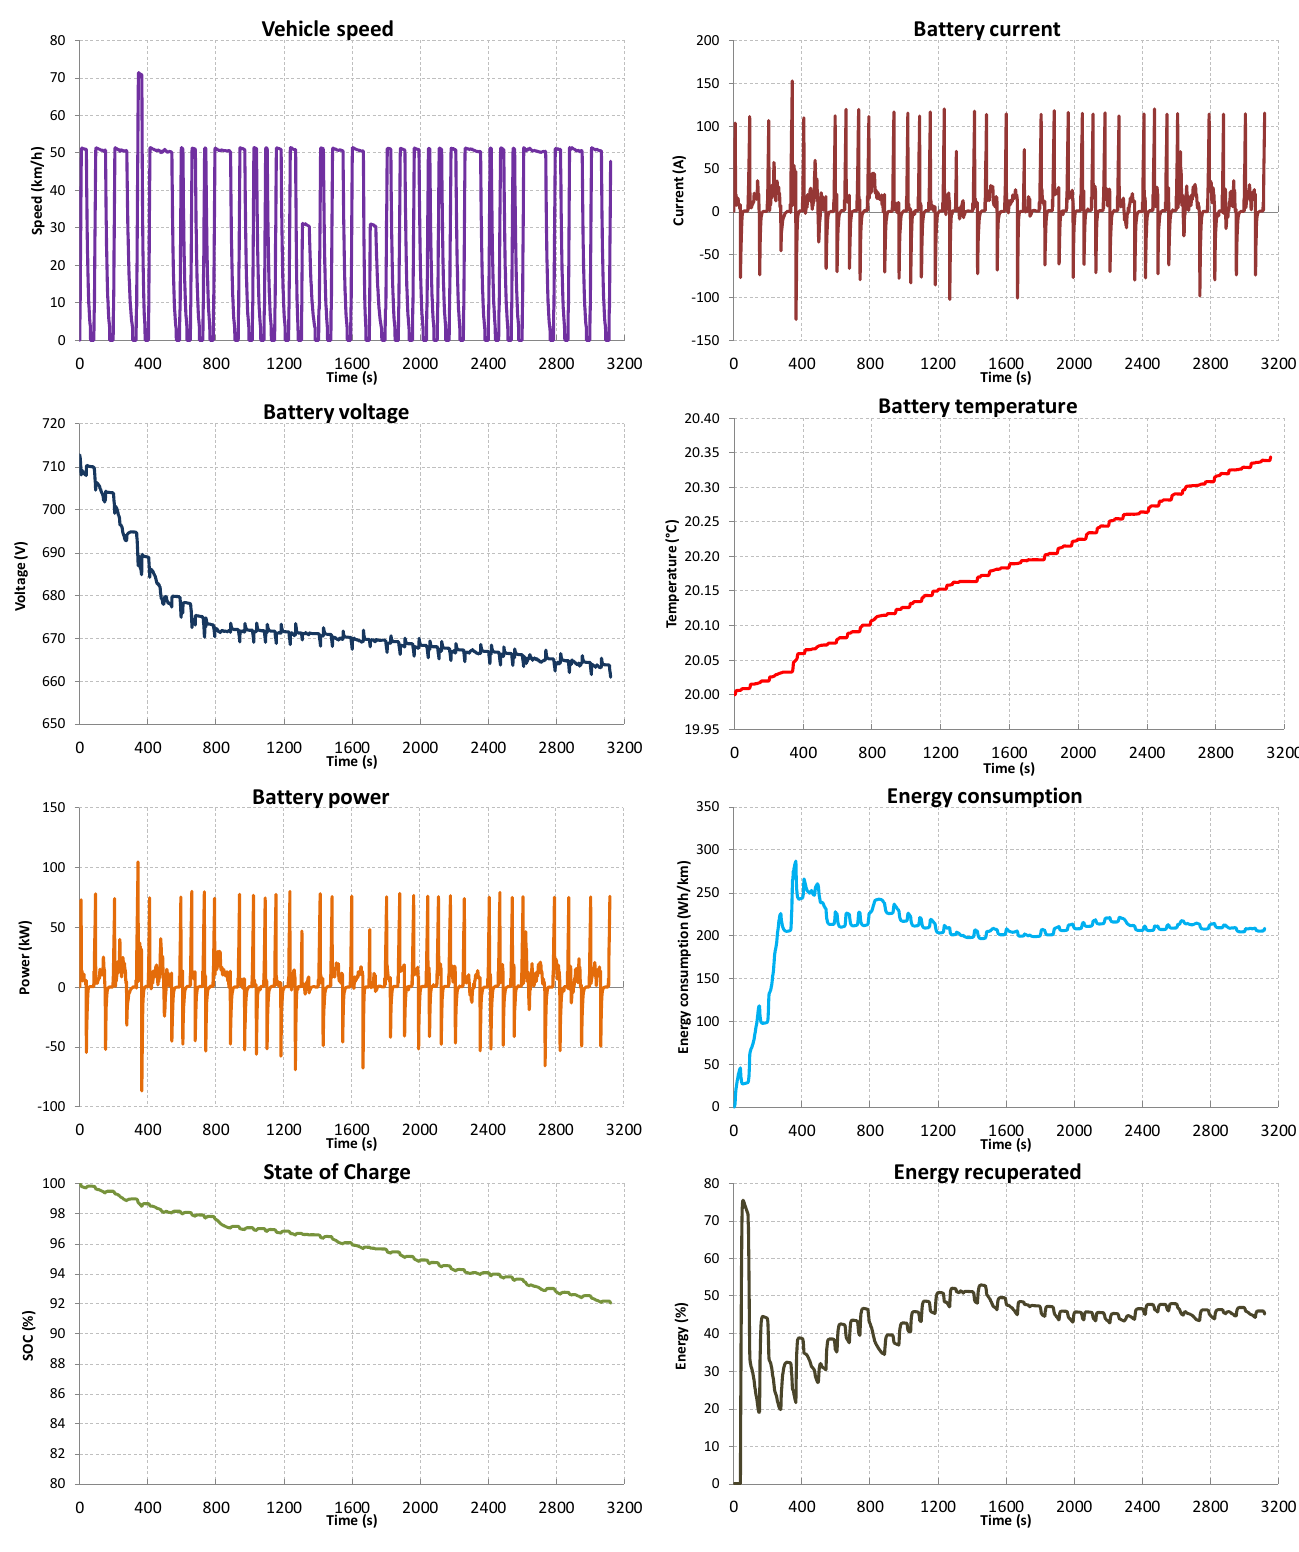
Figure 15. Results of simulation tests of the 4 × 2 drive system on the Gdynia-Flat route.